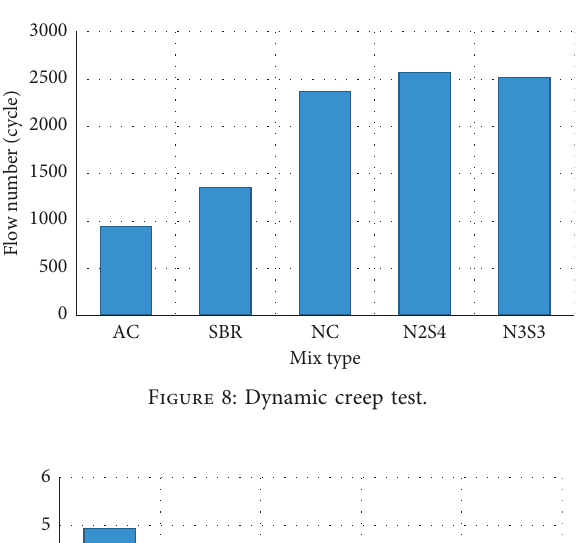
Figure 4: Penetration index. Table 4: Storage stability.